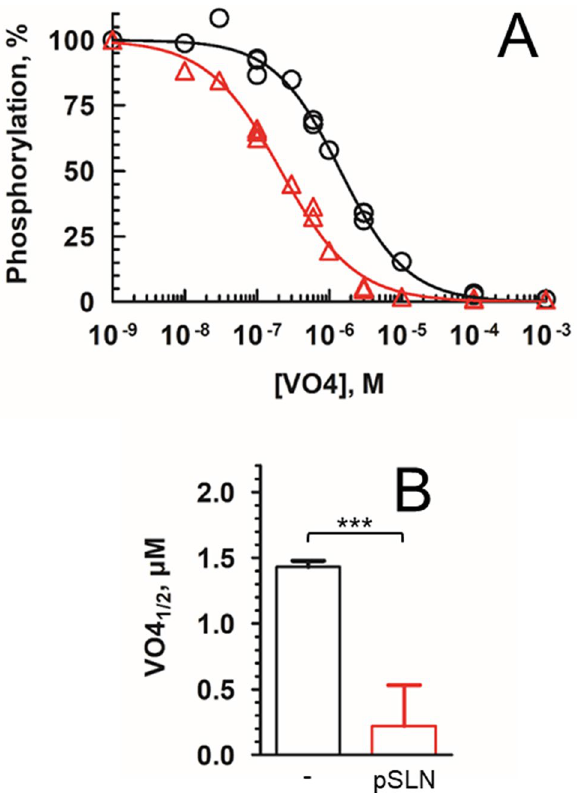
Figure 6. Effect of SLN on the binding of orthovanadate. The amount of phosphorylated intermediate was assayed after preincubation with various concentrations of orthovanadate, for the recombinant enzyme alone (black circles) or supplemented with pSLN (red triangles). ( A ) The maximum level of phosphorylation reached in each case is indicated as 100%. EPmax were 2.01 ± 0.05 and 2.07 ± 0.21 nmoles/mg of ATPase, respectively. All the data points are shown and are from three independent experiments. Data were fitted with a “one-site specific binding law” with Hill slope. nH are 0.99 ± 0.04 and 0.95 ± 0.06, respectively, thus in agreement a unique binding site. ( B ) Apparent affinity for vanadate as deduced from panel A. K 1/2 are 1.43 ± 0.08 µM and 0.22 ± 0.01 µM, respectively, with p <